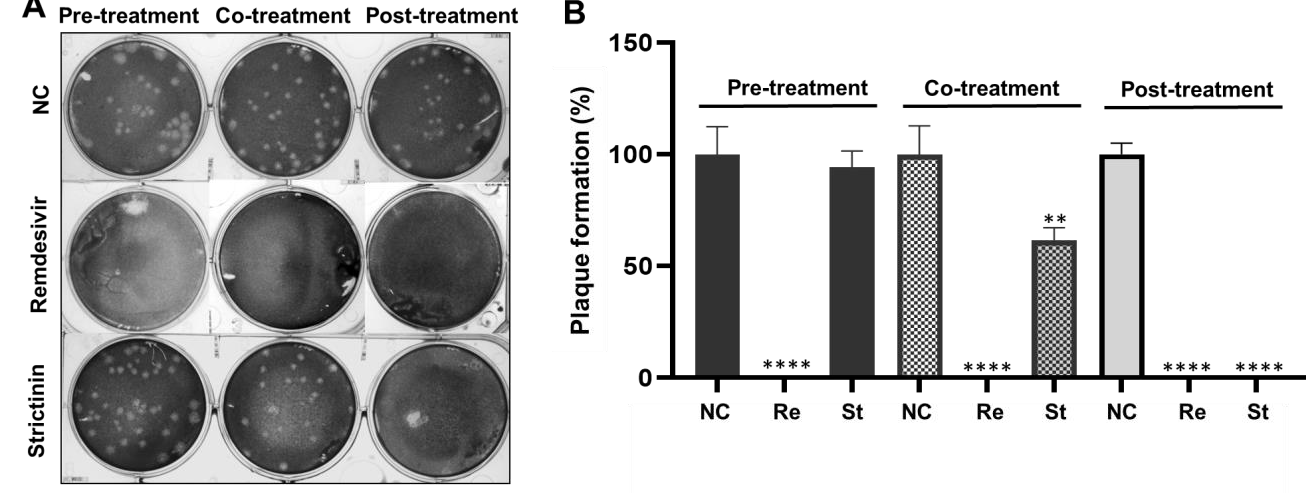
Figure 5. Evaluation of the effects of remdesivir and strictinin on MHV infection by plaque reduction assay. ( A ) MHV infection of mouse L cells was set at 100 PFU/well. A time-of-drug addition test was used in the plaque reduction experiment. Mouse L cells were pre-, co-, or post-treated with remdesivir (Re) of 20 µ M or strictinin (St) of 100 µ M. NC was a negative control group with only MHV. ( B ) The relative numbers of virus plaques treated with remdesivir and strictinin were calculated by using the plaque number in the NC group as 100%. All data were presented as mean ± S.D. ( n = 3). ** p < 0.01 and **** p < 0.0001, indicating significant difference from NC, were analyzed using